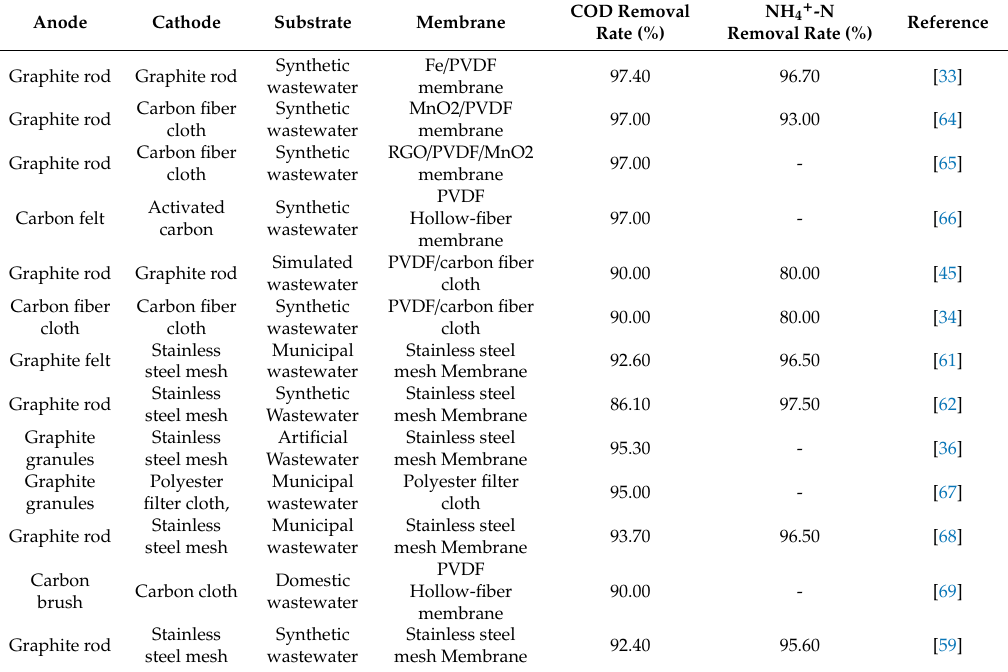
Table 2. The COD removal rate and NH 4 + -N removal rate in di ff erent microbial electrocatalysis systems coupled with MBR